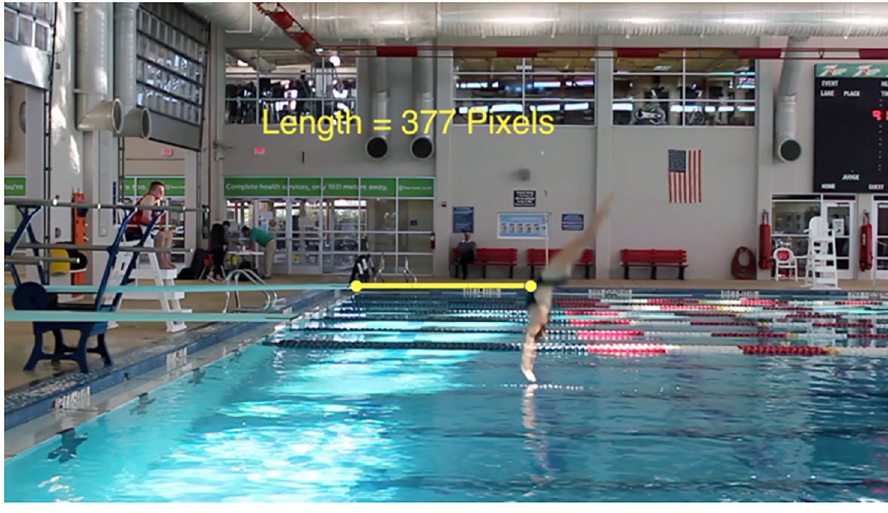
Fig 1. Measuring distance from the diving board at entry. Still photo illustrating how distance of the diver from the board was measured from the recorded footage.